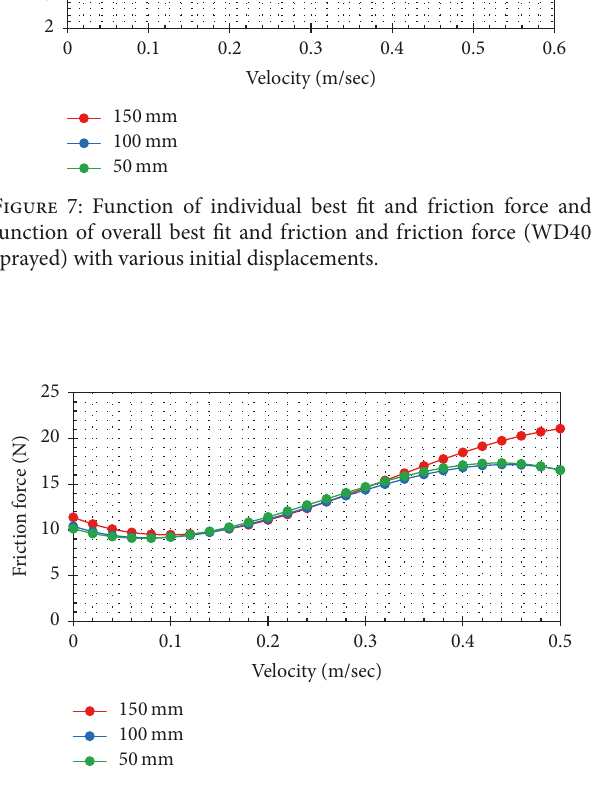
Figure 8: Function of individual best fit and friction force and function of overall best fit and friction and friction force (WD40 whipped) with various initial displacements.